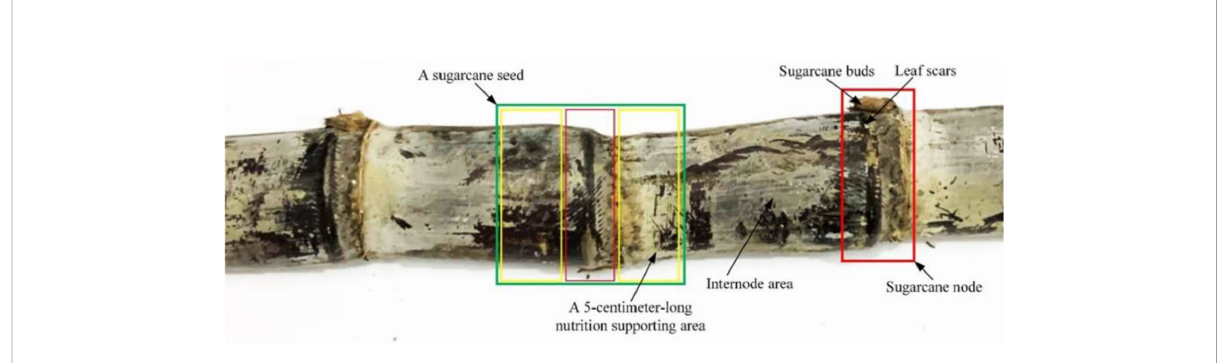
FIGURE 2 Description of sugarcane seed cutting